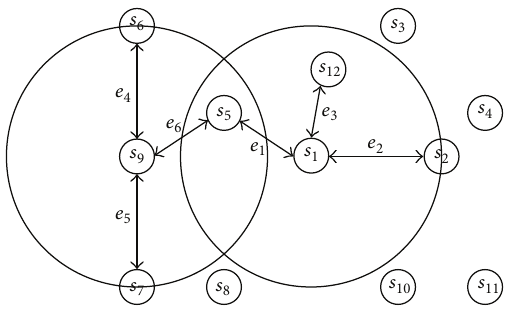
Figure 1: Arbitrary network topology based on unit disk model.